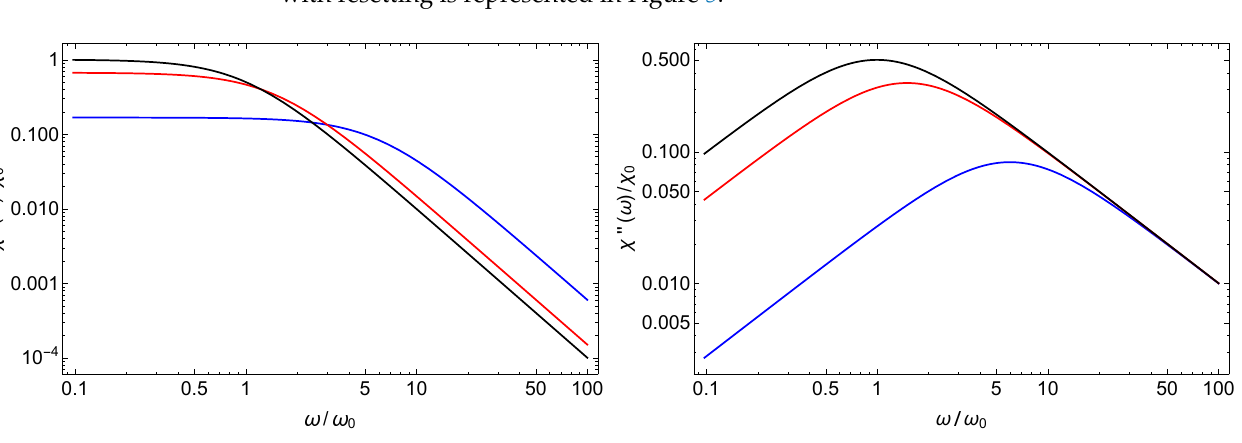
Figure 5. Behaviour of the complex susceptibility (log–log plot) for Debye relaxation with resetting. The black line corresponds to Debye relaxation without resetting, while the red and blue lines correspond to r -parameter values of 0.5 and 5, respectively. Left panel : real part. Right panel : imaginary part (dielectric